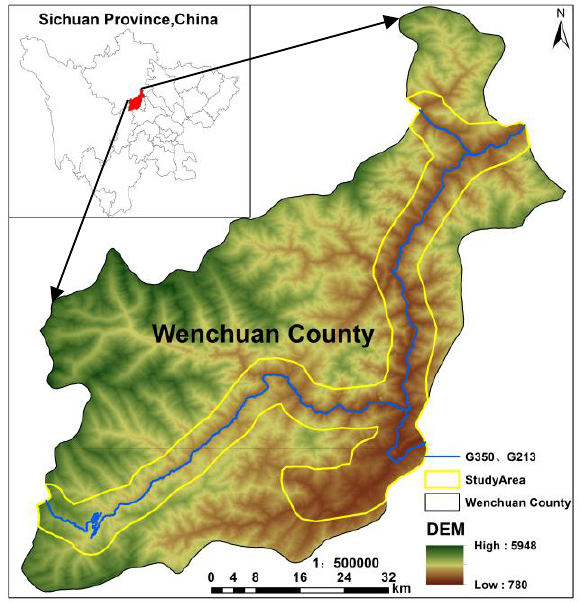
Figure 1 . The study area: Wenchuan County.